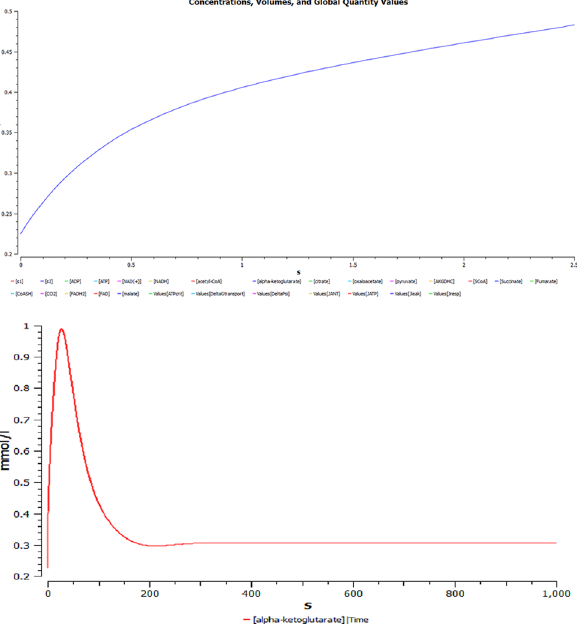
Fig 12. Graph between different concentration of AKGDHC. (a) rate of ATP generation with respect to time and (b) Pyruvate concentration with time.